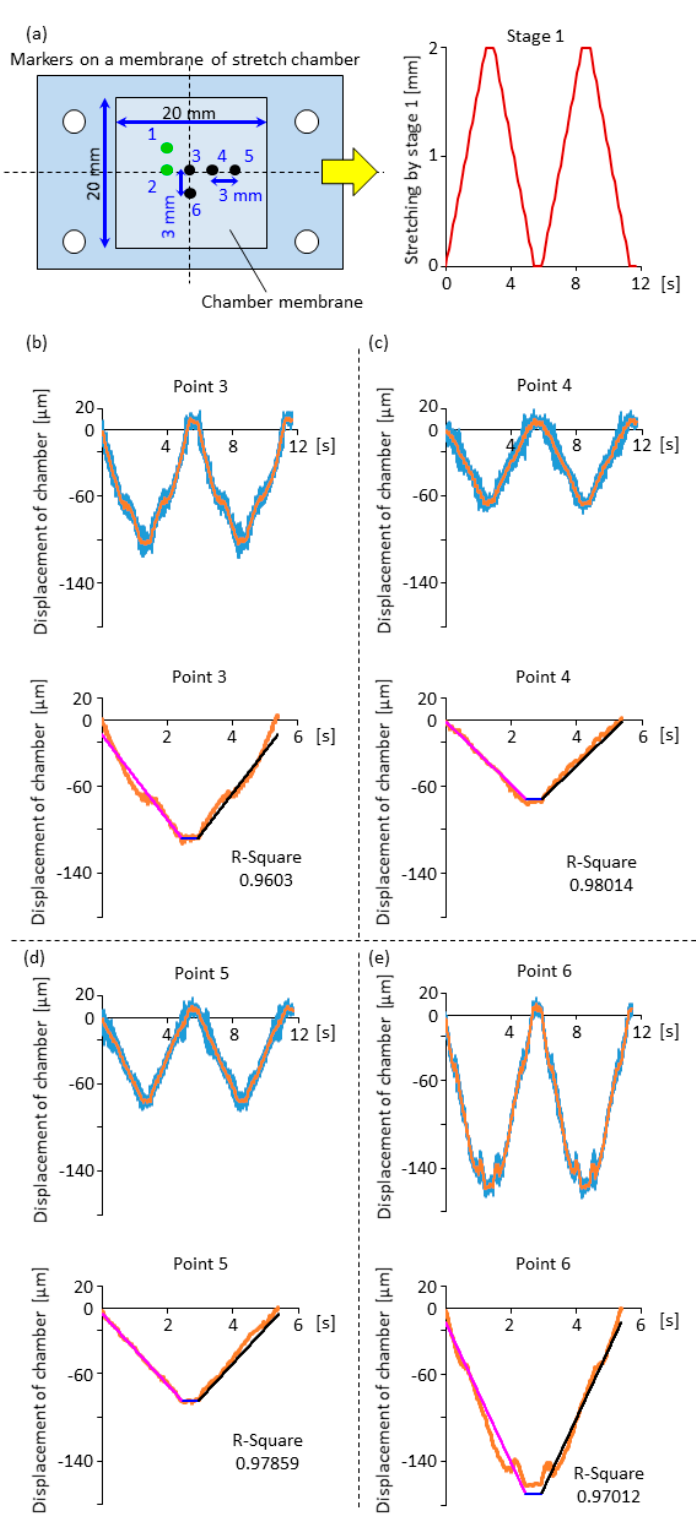
Figure 5. Vertical displacement trajectories of targets on the chamber membrane. ( a ) The layout of targets on the chamber membrane and the waveform for the control of stage 1 / chamber stretching. ( b – e ) Upper: a typical waveform of points 3–6 when the chamber was stretched. Lower: the fit results of the stretching / holding / relaxation phases of the corresponding upper waveform. From ( b ) to ( e ), original data is in light blue and filtered data in orange. The lines with color in purple, blue, and black are the lines fitting for the lengthening, holding, and relaxation phases,